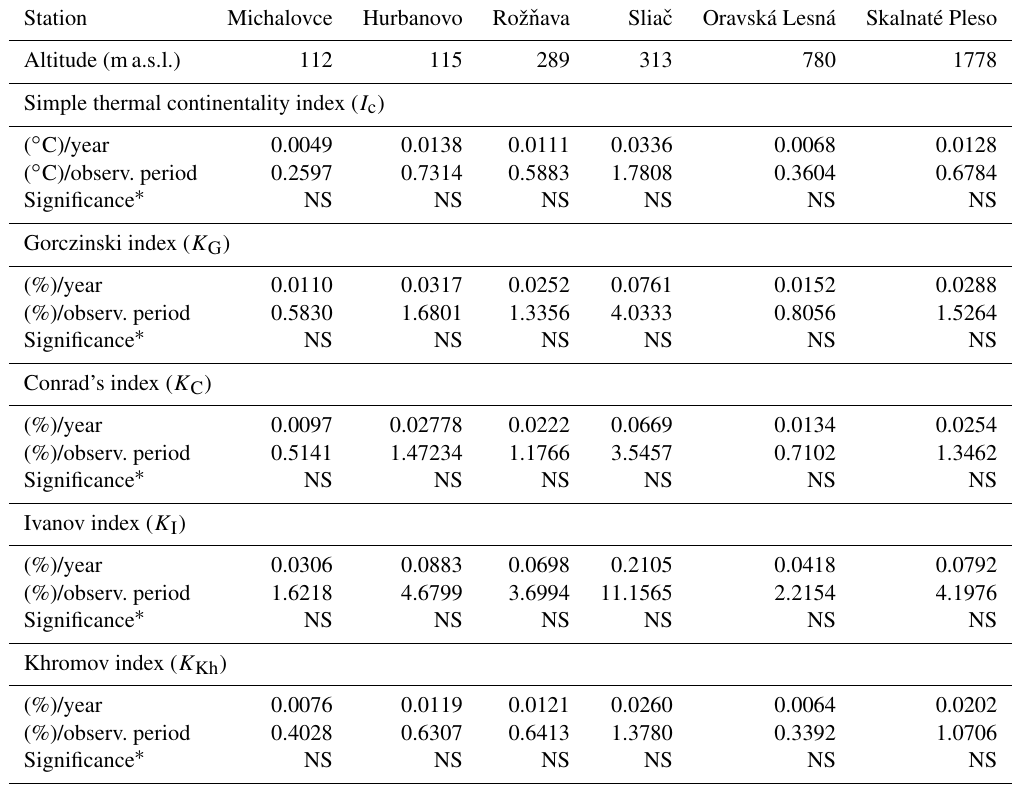
Table 4. The linear trend values (units/year; units/observed period) and statistical significance levels of five continentality indices: continen- tality index ( I C ), Gorczynski ( K G ), Conrad ( K C ), Ivanov ( K I ) and Khromov ( K Kh ) for the period 1961 to